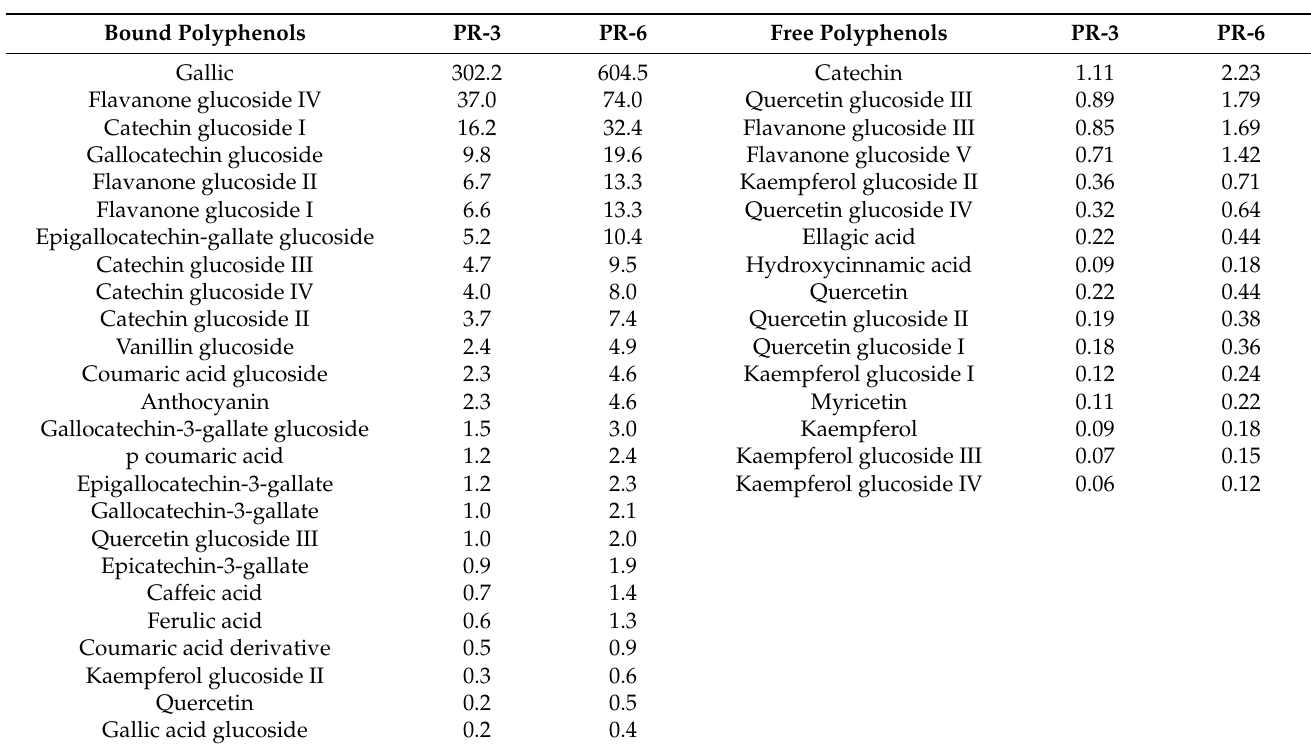
Table 3. Theoretical number of polyphenols in enriched pork liver p â t é samples calculated based on their mean amount in persimmon flour. Values expressed as µ g/g